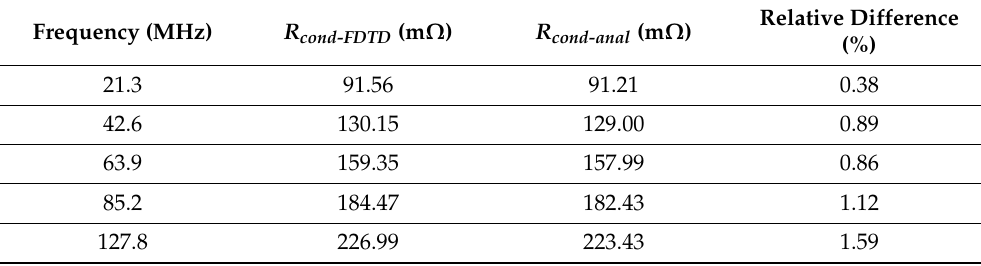
Table 4. Coil conductor resistance estimation for different frequencies ( n = 8-segment loop). FDTD and analytical calculation results.